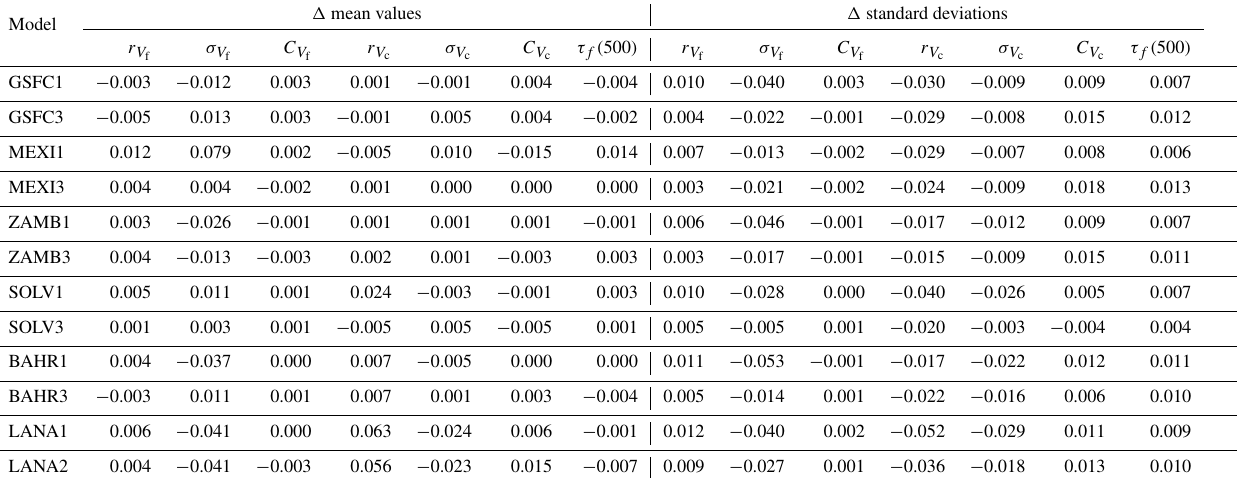
, r V [µm]), geometric standard deviation ( σ V c f